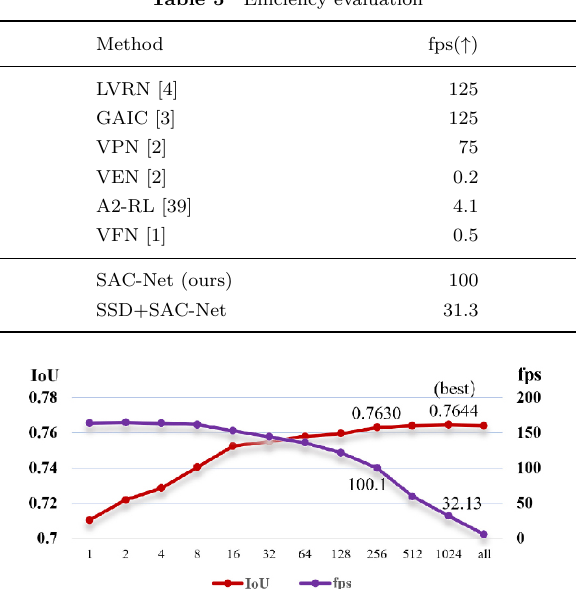
Fig. 11 Varying use of candidate score map. We show IoU and fps values using cropping windows whose scores in the candidate score map are in the top 1, 2, 4, 8, 16, 32, 64, 128, 256, 512, 1024,